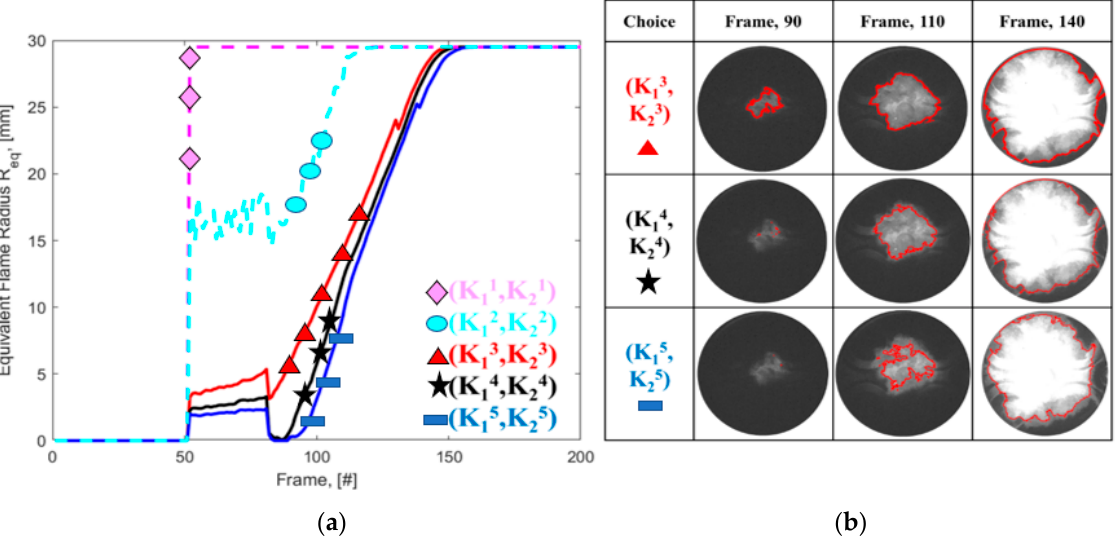
Figure 6. ( a ) Examples of R eq not suitable to reproduce the increasing trend of the flame radius during the development of the combustion process and R eq (solid lines) that may be considered potentially suitable for reproducing the same combustion physical phenomenon. ( b ) The figures on the right depict the contouring process, for the potentially right cases, applied to detect the capability of BR in reproducing the flame front of the original images. (K 13 , K 23 ) choice allows to better reproduce the flame front and therefore can be considered as the best choice to select.